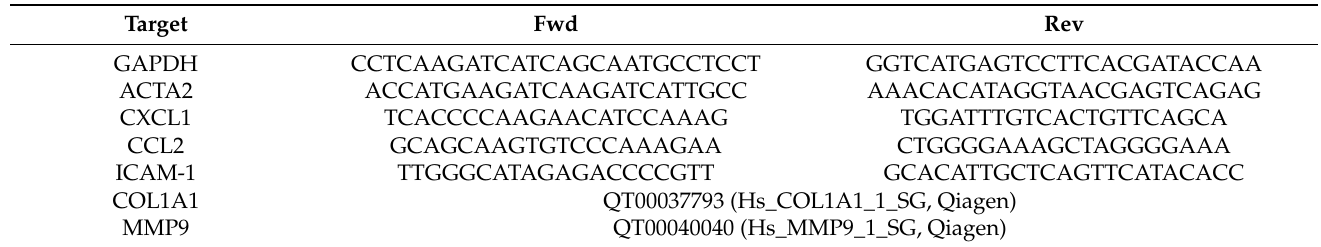
Table 1. List of primers used for qPCR